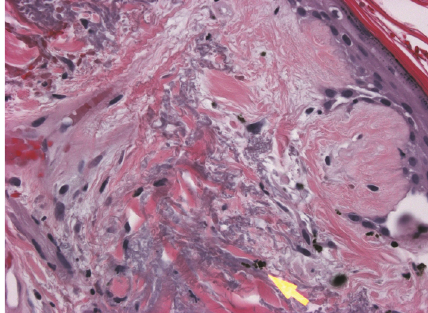
Figure 4: Melanin incontinence into dermis (yellow arrow) (H&E 400x).